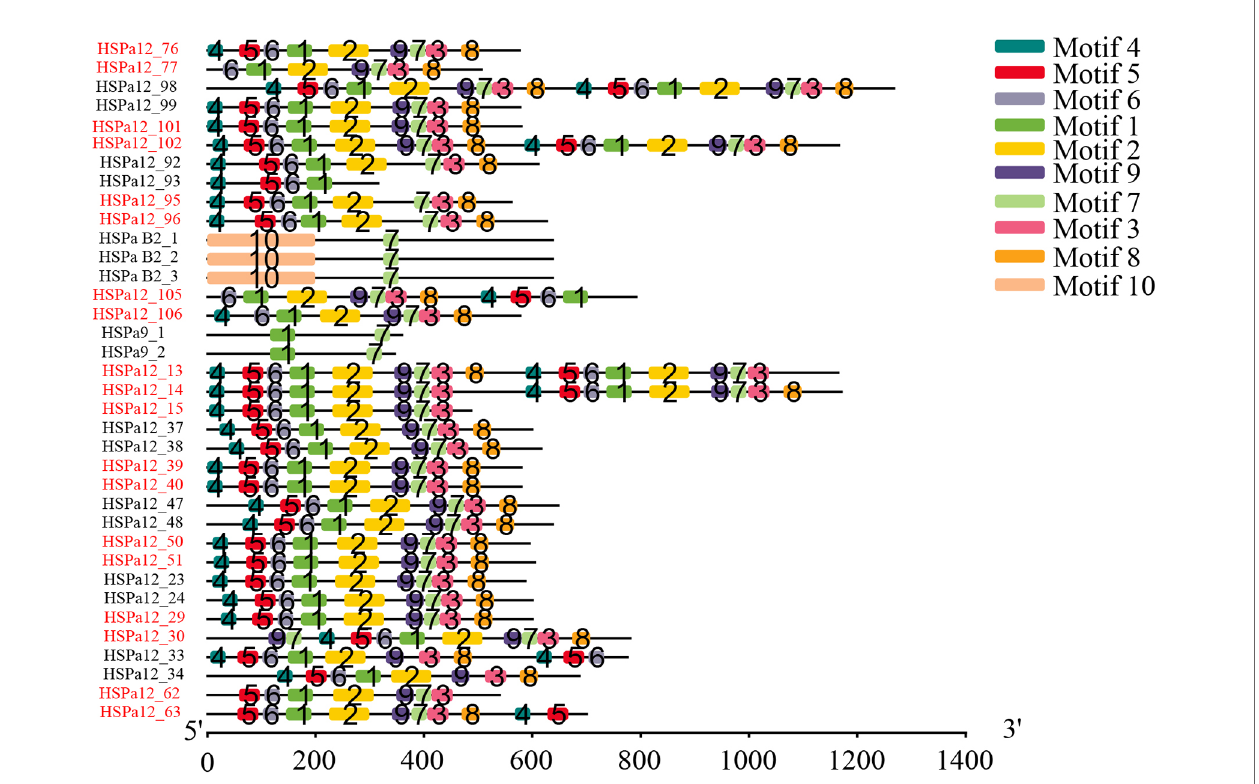
FIGURE 3 | Distribution of conserved motifs in tandem duplication MmHSP70 gene pairs. The tandemly duplicated gene pairs were shown by adjacent two or three genes with the same